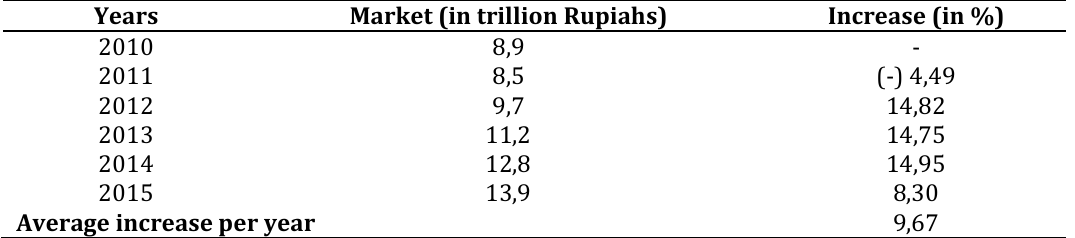
Table 1: The development of cosmetics market industry in Indonesia (2010-2015) Years Market (in trillion Rupiahs) Increase (in %) 2010